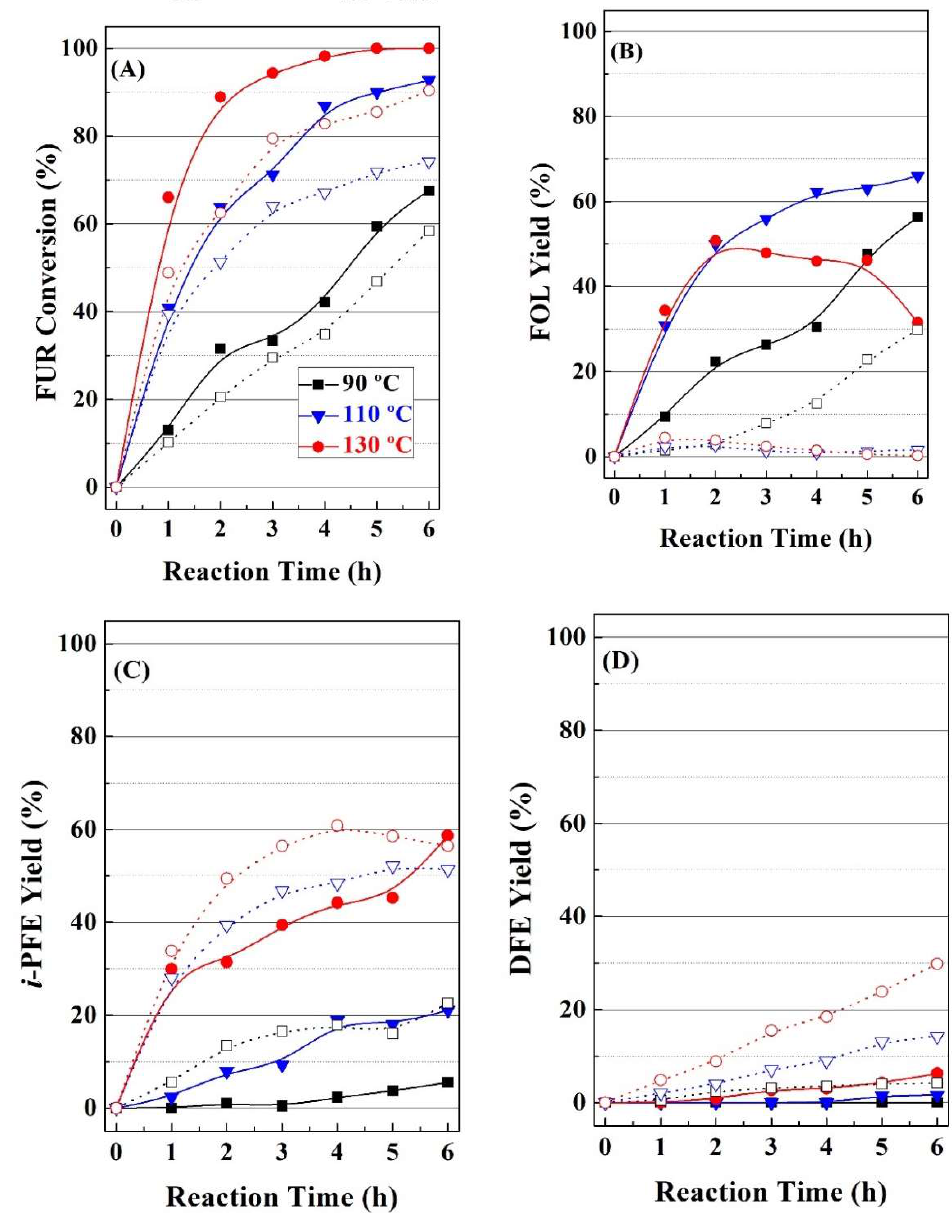
Figure 8. ( A – D ) Influence of the temperature on the catalytic performance using RT and HT-TMB catalysts for the MPV reaction of FUR. (Experimental conditions: 0.1 g of catalyst, i -POH/FUR molar ratio: 50, FUR/Catalyst mass ratio: 1).